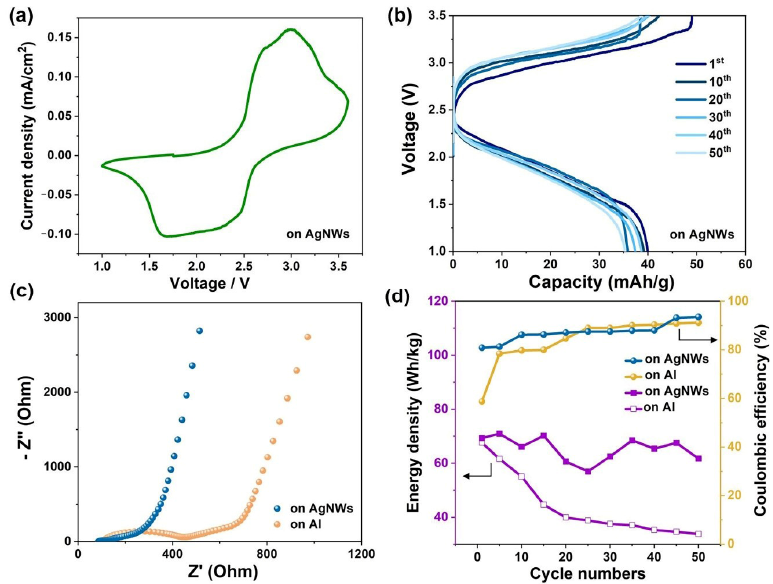
Figure 4. Electrochemical properties of aqueous LMO//LTO full cells using AgNWs as current collectors. ( a ) Cyclic voltammetry curve of the LMO//LTO full cell under a scan rate of 0.1 mV/s. ( b ) Galvanostatic charge–discharge behavior of the LMO//LTO full cell under a current density of 17.5 mA/g (based on the mass of the LTO) for 50 cycles. ( c ) Nyquist plots of as-assembled LMO//LTO full cells using AgNWs and Al foil as current collectors. ( d ) Energy densities (based on the total mass of the cathode and anode) and the Coulombic efficiency of the full cells cycled under a current density of 17.5 mA/g (based on the mass of the